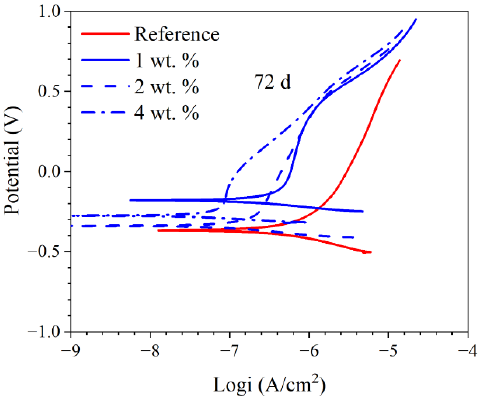
Figure 12. PD curves of the reinforcement embedded in concrete immersed in 3.5 wt.% NaCl solution at different ages (7 d, 14 d, 28 d, 56 d and 72 d).